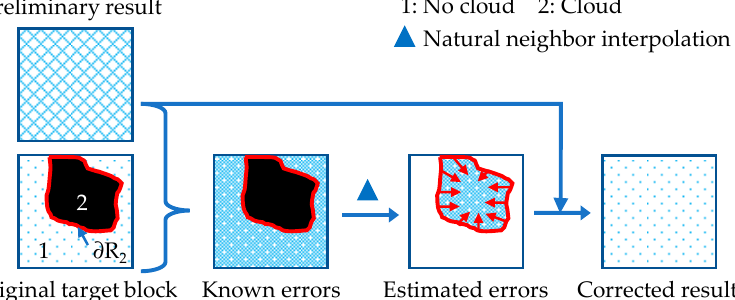
Figure 5. Schematic diagram of the error correction.